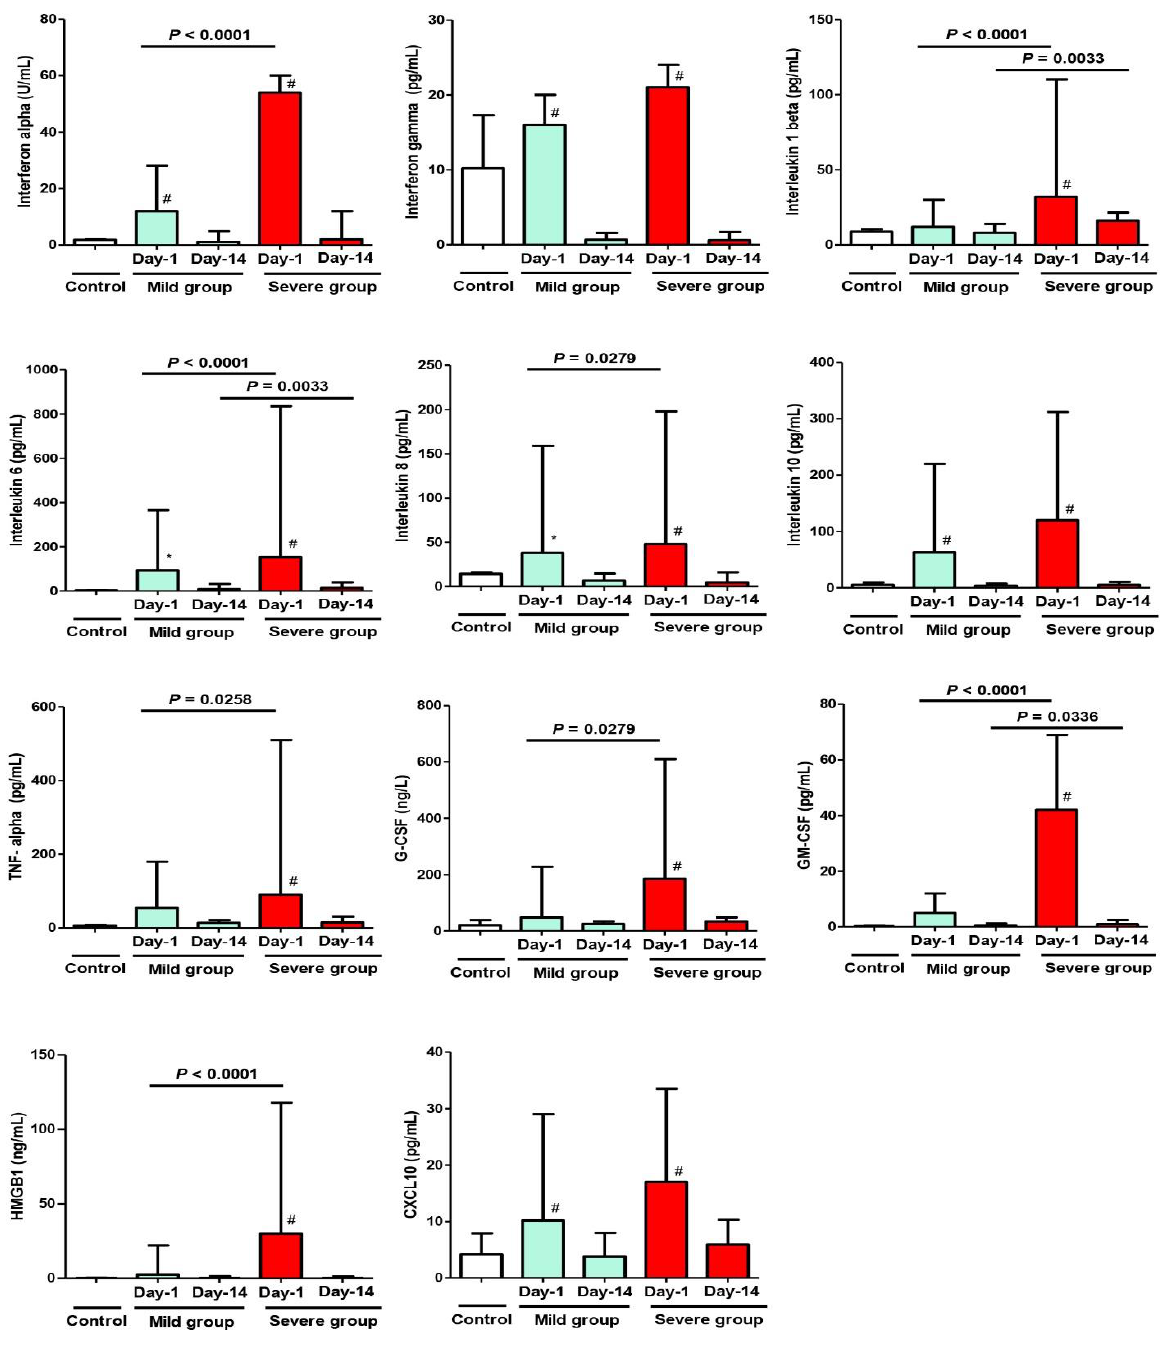
Figure 4. Cytokine analysis at Day 1 and Day 14 after admission with MIS-C manifestations. Control Group = Simple COVID-19 infection; Group A = Mild MIS-C; Group B = Severe MIS-C. * p < 0.05 and # p < 0.01, statistically significant difference compared to the control group (one-way ANOVA followed by Tukey’s